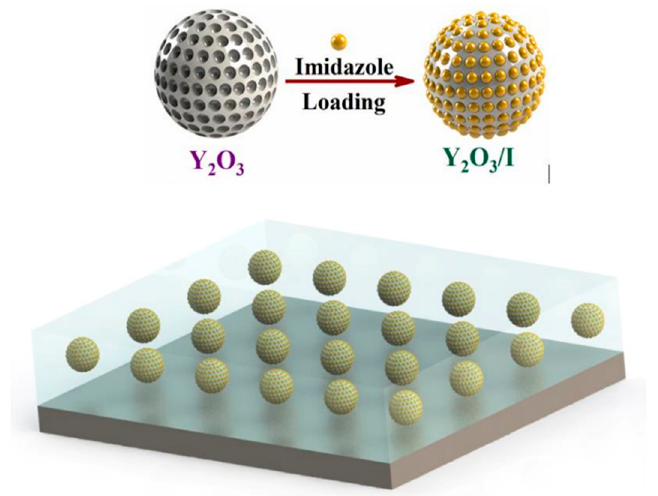
Figure 1. The pictorial representation of infusing Y 2 O 3 using imidazole in the epoxy coating. Reprinted with permission from Ref. [35]. MDPI (2021).